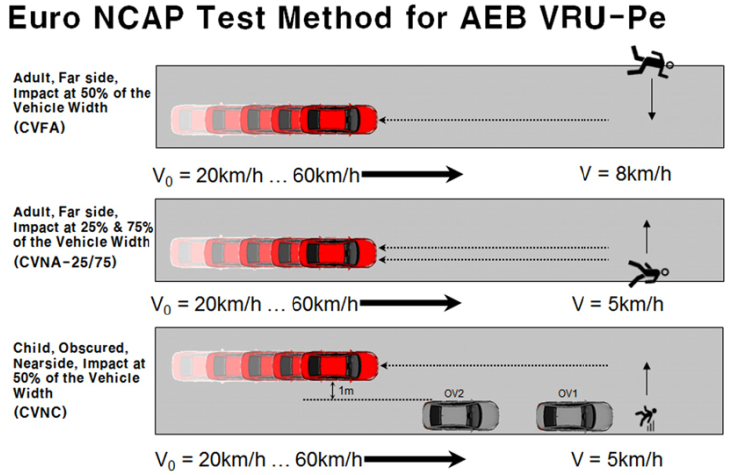
Figure 7. AEBS VRU-Pe scenario of Euro NCAP test method.